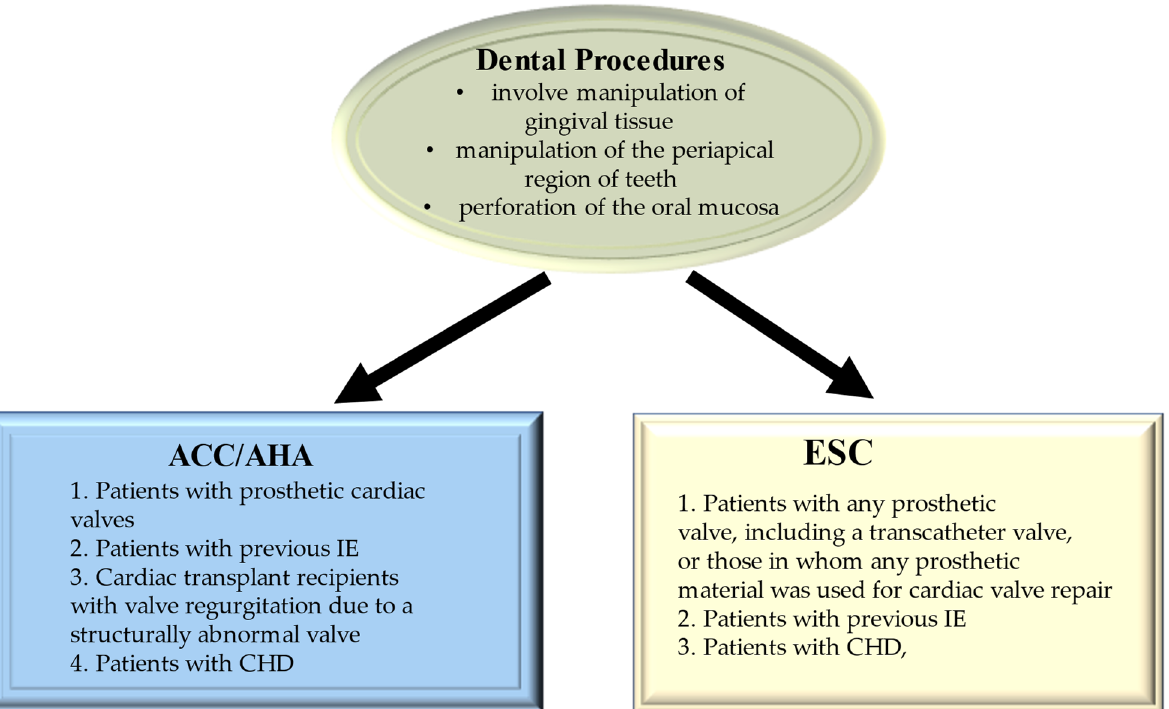
Figure 11. 2020 ACC/AHA and 2021 ESC Guidelines on Use of Antibiotic Prophylaxis for the Prevention of Infection of Heart Structure. Abbreviations: ACC; American College of Cardiology; AHA, American Heart Association; ESC, European Society of Cardiology.